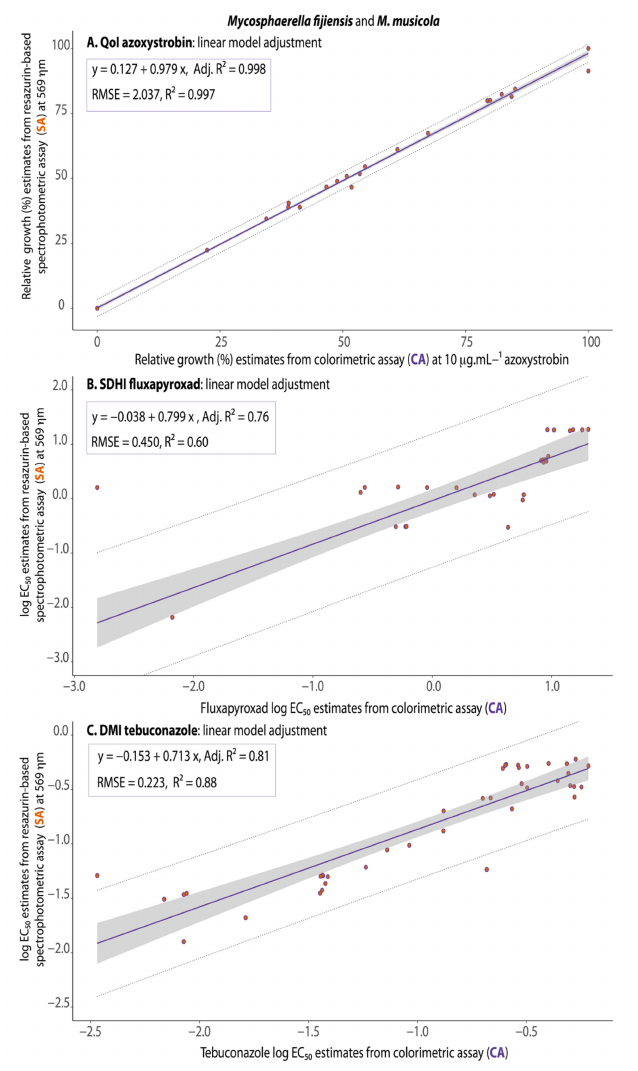
Figure 6. Simple linear regression models predicting the correspondence between the log EC 50 or fungus relative growth estimates from the spectrophotometric assay at 569 nm (SA = SPEC-assay) on the basis of log EC 50 or relative growth estimates from the colorimetric assay (CA = COL-assay) for QoI ( A ), SDHI ( B ), or DMI ( C ) fungicide sensitivity testing for Mycosphaerella fijiensis and M. musicola a,b . a The rectangle within each figure contains the corresponding linear equations, the adjusted R 2 (Adj. R 2 ) as a measure of precision of the colorimetric assay, and the model fit parameters ( RMSE and R 2 ). In all three cases the linear regression had the best fit as a predicting model, with the lowest RMSE and the highest R 2 . b The regression lines were presented in purple, the confidence interval band of the prediction model in gray and the distribution of the values by orange circles contained within the limits of dotted